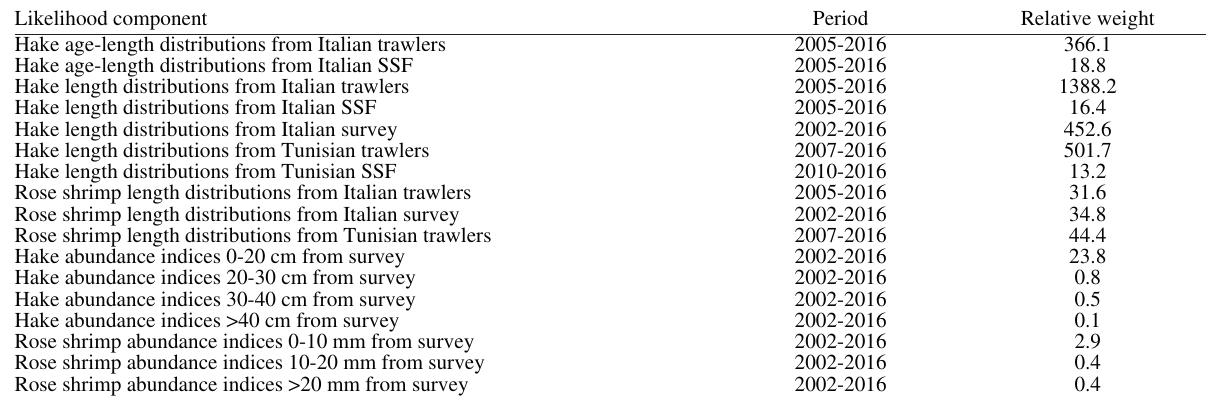
Table 2. – Likelihood components, time period covered and their relative contribution to the final total likelihood (SSF: small-scale fishery). Likelihood